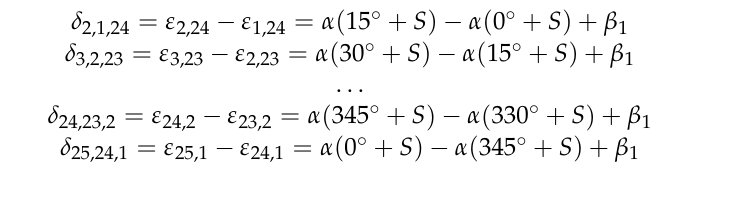
Table 2. According to the same procedure, the values listed in the fourth column ε i3 reduce